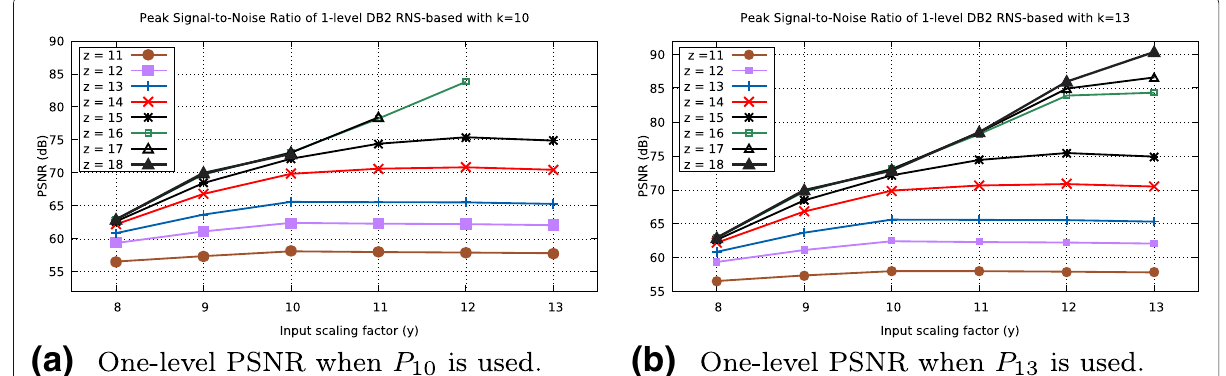
Fig. 12 The impact of input, y , and wavelet filter coefficients, z , scaling factors of one-level RNS-based implementation on PSNR, with respect to ( a ) P 10 and ( b ) P 13 moduli